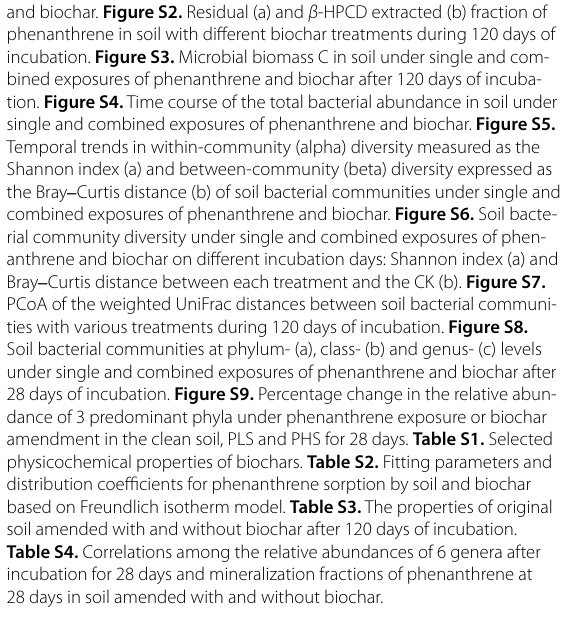
Table S4. Correlations among the relative abundances of 6 genera after incubation for 28 days and mineralization fractions of phenanthrene at 28 days in soil amended with and without